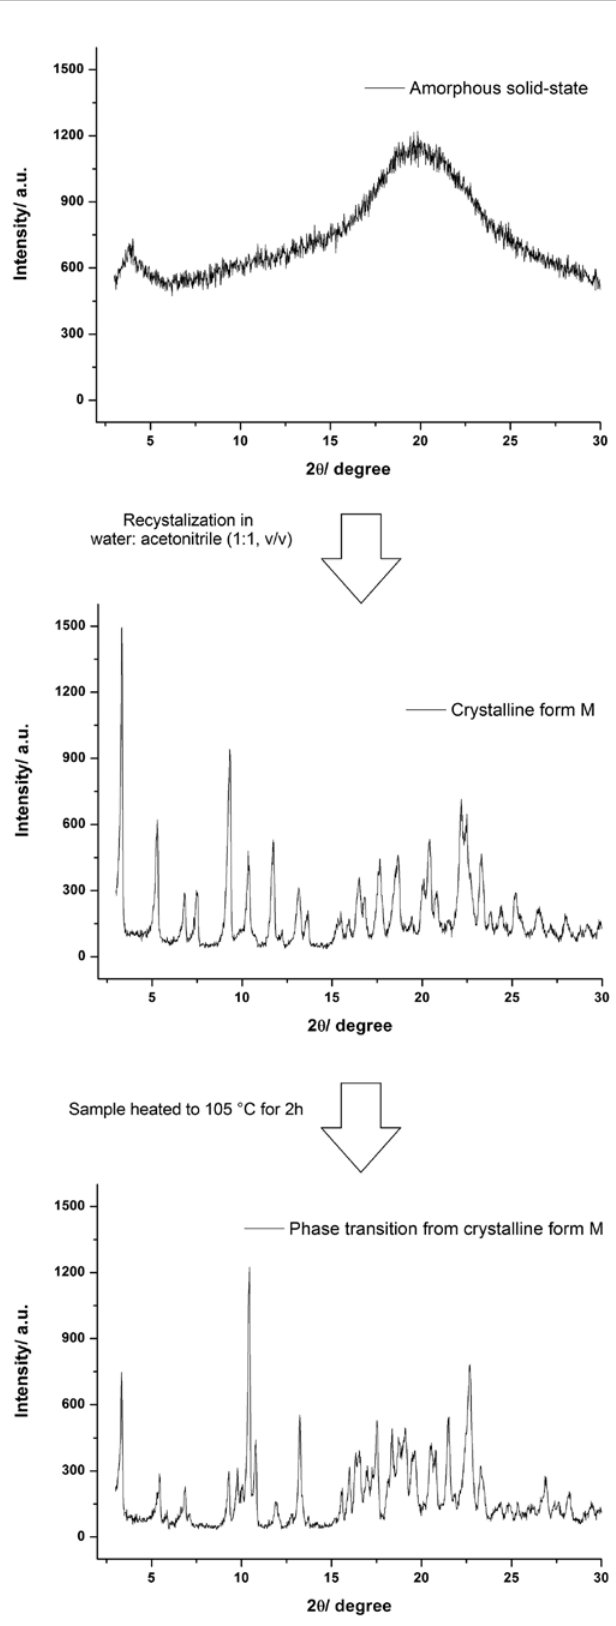
FIGURE 3 - XRDP of ROSC: amorphous solid-state; crystalline form M, and its phase transition after heating to 105 °C for 2h.